Question: Sum up the contents of this chart in one sentence.
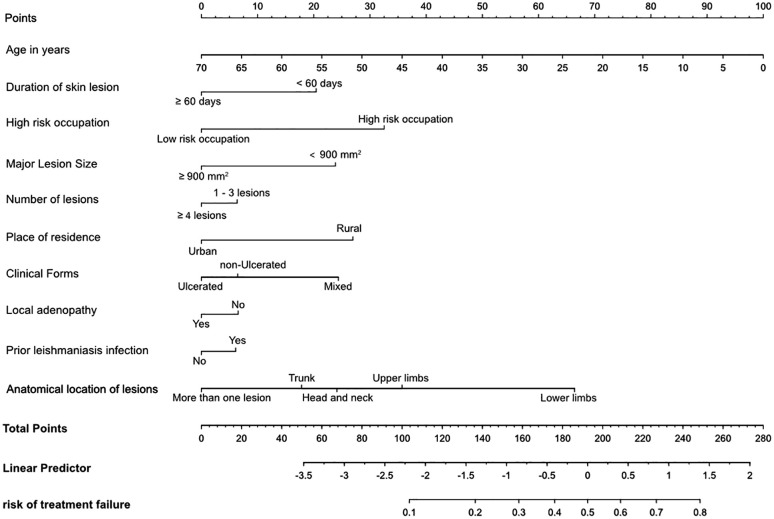
Answer: Nomogram for predicting TF. The nomogram was composed of 10 variables. The nomogram is used as follows: the first horizontal line displays the points; the reader locates how many points each predictor has according to the patient’s characteristics, and then adds up the points and locates the total number of points on the last horizontal line. Finally, the reader draws a vertical line from the total number of points and obtains the probability of TF. High-risk occupations: including military personnel and agricultural workers.